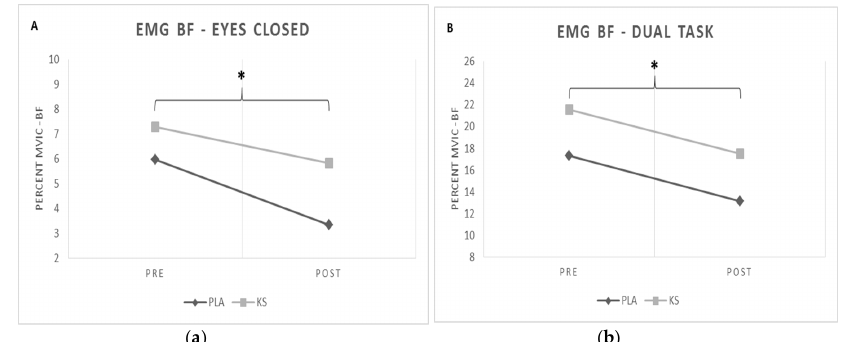
Figure 4. Mean EMG percent maximal voluntary isometric contraction (%MVIC) during eyes closed ( a ) and eyes open dual-task; ( b ) postural stability tests, before (PRE) and after (POST) the treadmill workload in firefighters. Groups: Placebo (PLA) and Ketone (KS) for biceps femoris (BF). * represents significant difference for biceps femoris in both groups between PRE and POST at p < 0.05.